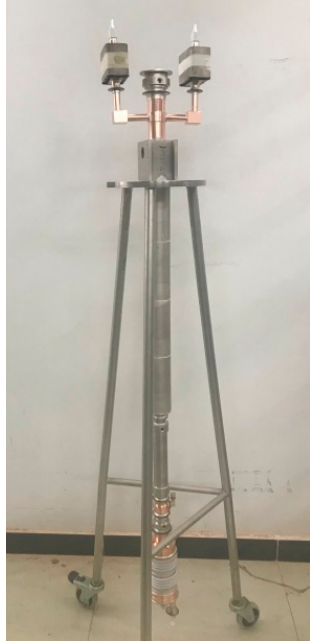
Figure 13. Prototype of the W-band TE 02 mode gyro-TWT. The hot test system diagram of the tube is shown in Figure 14. A driving signal which is generated by a W-band signal generator is amplified by a W-band solid state amplifier and a W-band TWT. The maximum output power of the W-band TWT is 150 W. The W- band gyro-TWT was installed on a superconducting magnet with a maximum magnetic field intensity of 4 T. The voltage of the W-band gyro-TWT is provided by a high-voltage